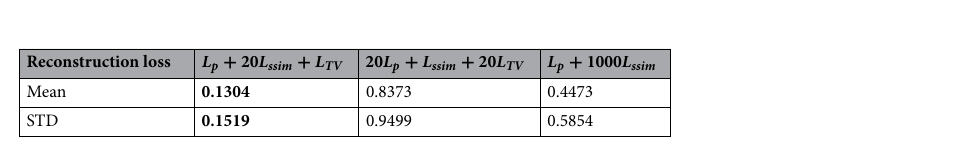
Table 3. Comparison of loss functions. Significant values are in bold.